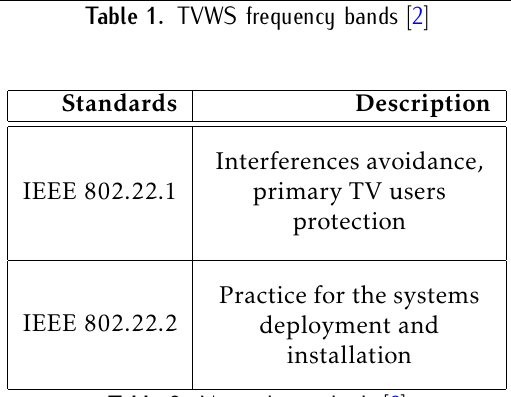
Table 2. Network standards